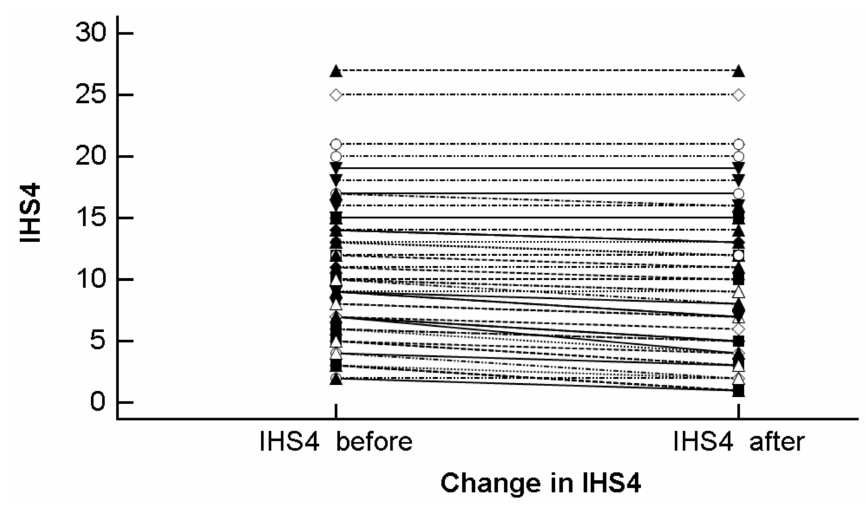
Figure 2. Change in the IHS4 score before (T 0 ) and after the Ramadan fasting (T 1 ).